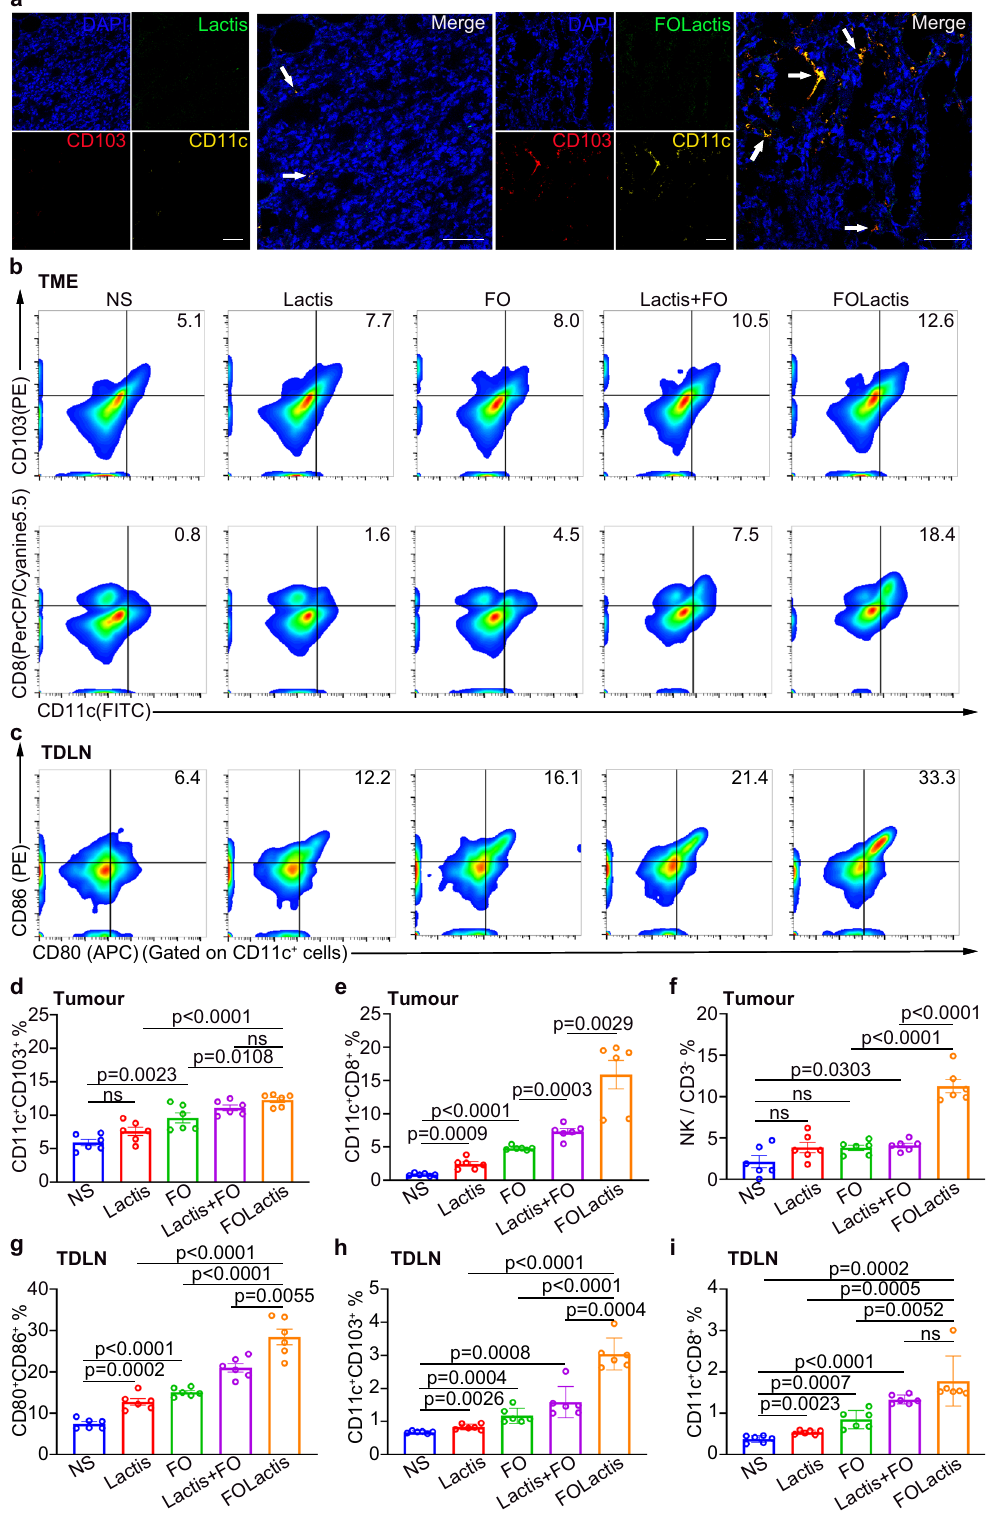
Fig.5|ISVwithFOLactisreprogrammedtheimmunemicroenvironmentinthe local tumor and TDLN. a Ex vivo immuno fl uorescence staining of CD11c + CD103 + DCs in the treated tumor 24h after intratumoural injection of Lactis or FOLactis (1×10 9 CFUpermouse).LactisorFOLactis,DCs,andtumornucleiwerelabeledwith DiO (green), anti-CD11c-PE antibody (yellow), anti-CD103-APC antibody (red), and DAPI(blue),respectively.Scalebars,50 μ m( n =3). b , c CT26tumor-bearingmicein different groups were sacri fi ced two days after the last treatment, and the propor- tionsofimmunecellswereanalyzedby fl owcytometryinthelocaltumorandTDLN